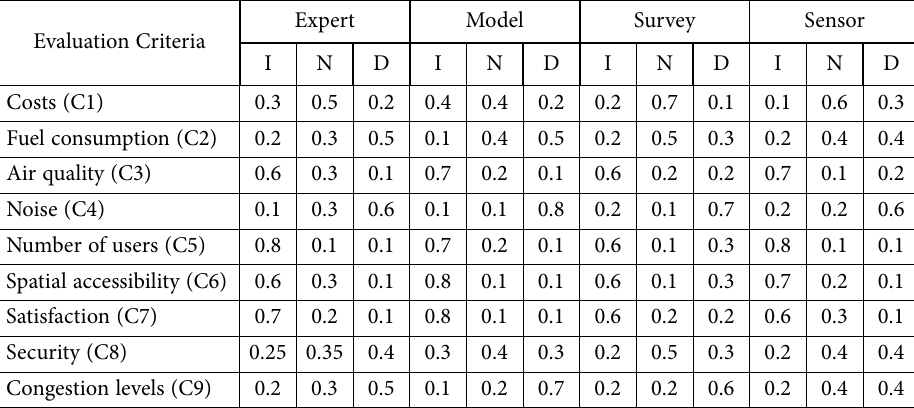
Table 2. Data collection (post-test stage) Evaluation